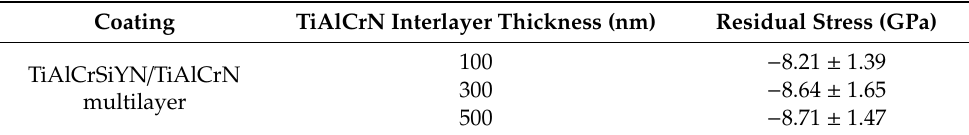
Table 3. Residual stress values in the studied coatings when E is 500 GPa for all crystal axis.